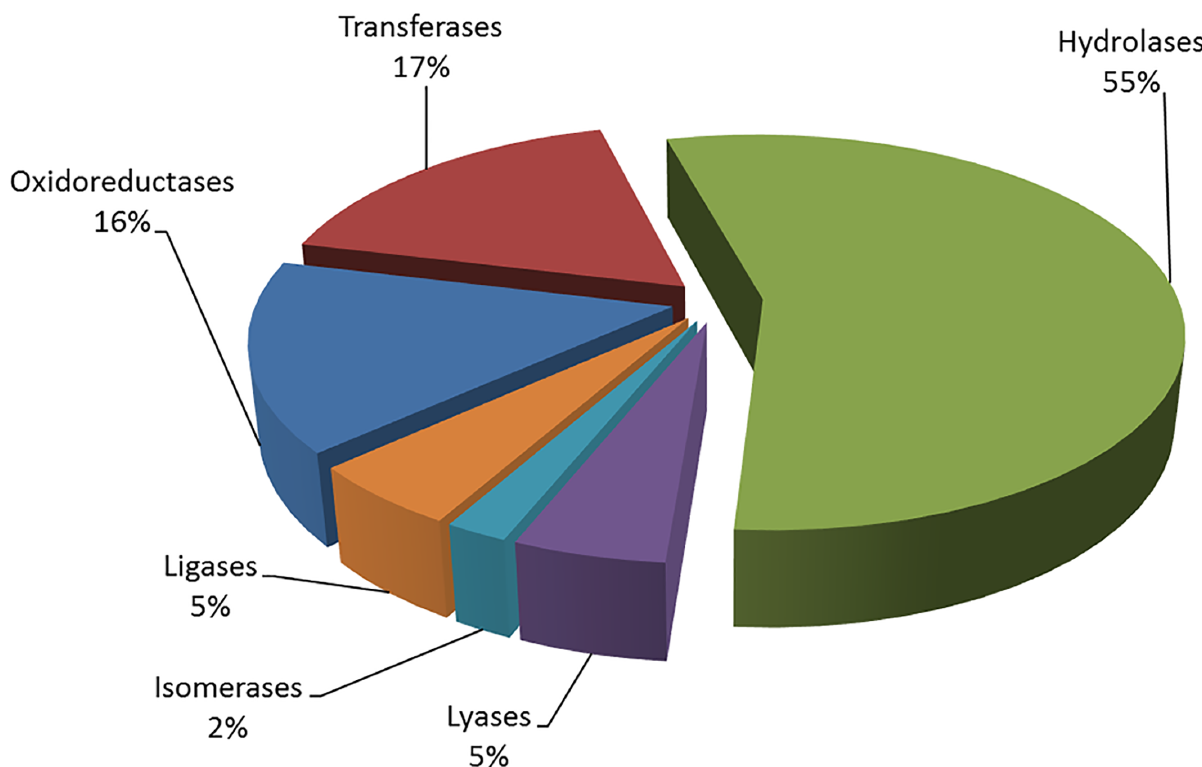
Fig 5. Annotated enzyme distribution of the six main enzyme families in the four DEG